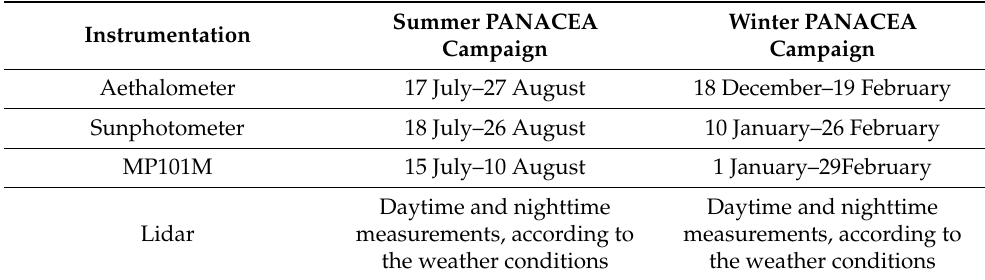
Table 1. Availability of the dataset of the instrumentation that participated in the two PANACEA